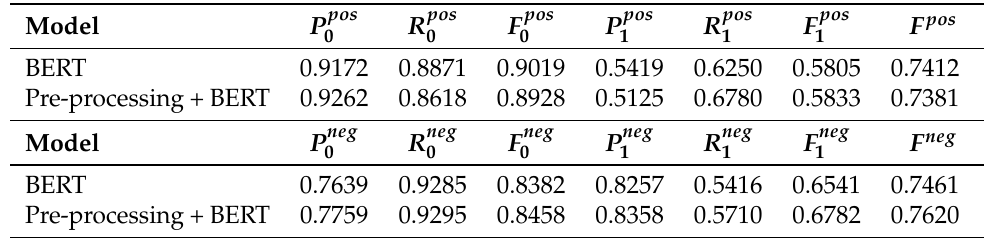
Table 7. Classification